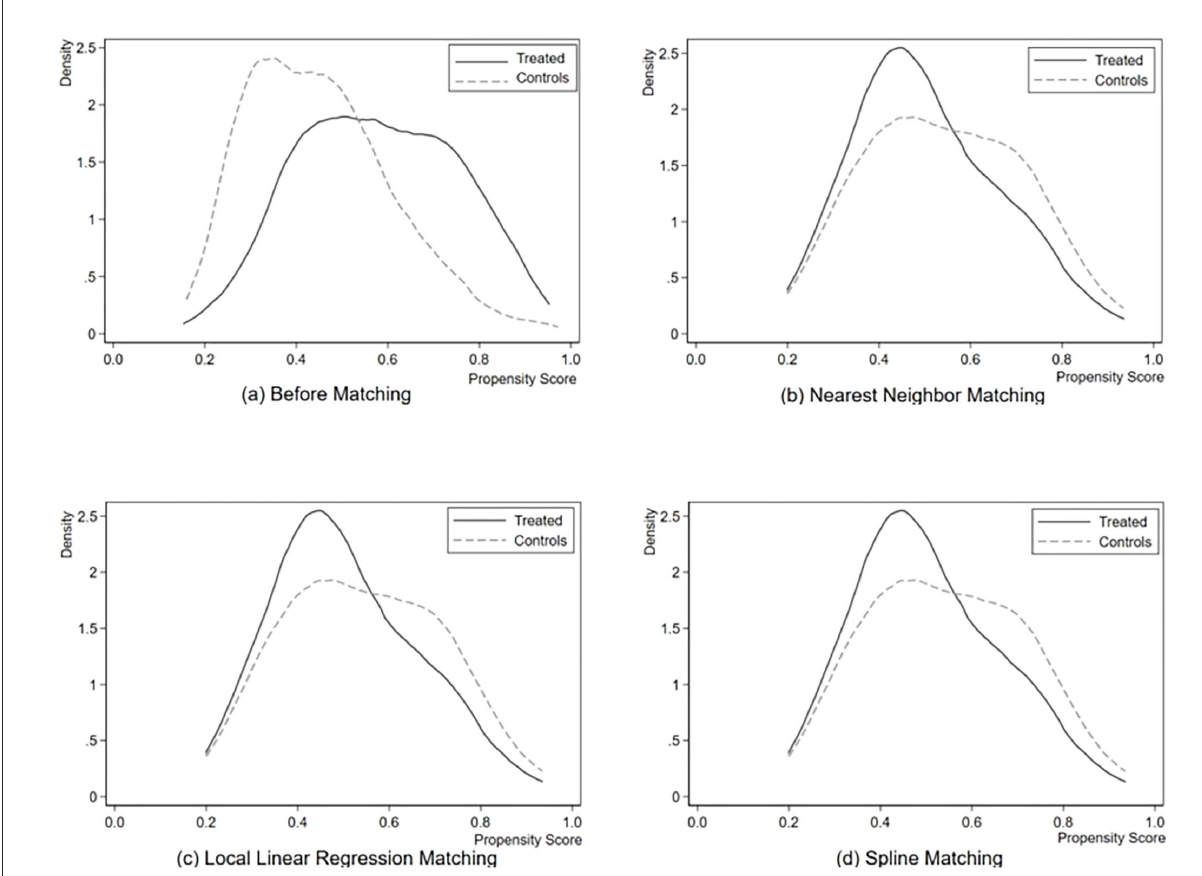
FIGURE3 Probability distribution of propensity score value between pre-processing group and control group.